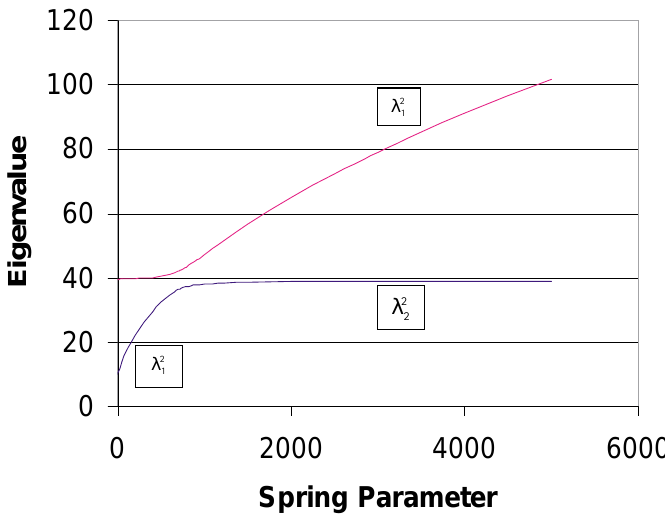
Fig. 6. Eigenvalues of simply supported beam with intermediate spring support (sine functions, α = 0 . 475